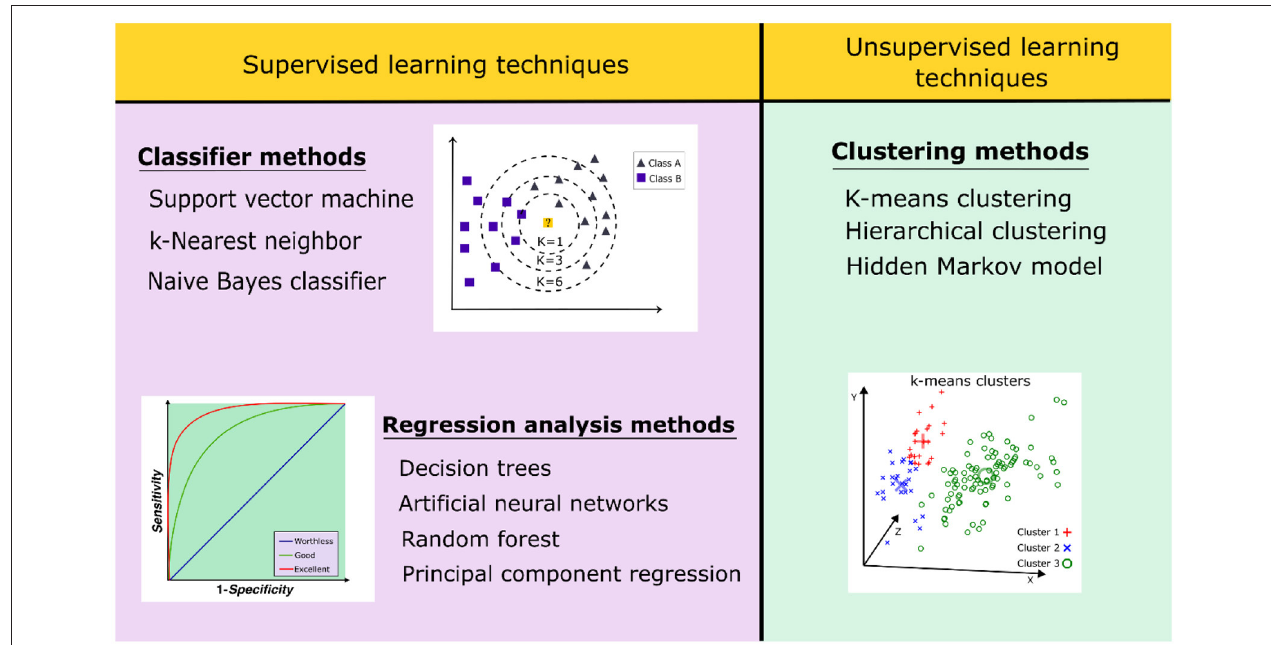
FIGURE 5 | Classification of supervised and unsupervised learning techniques applied in virtual screening